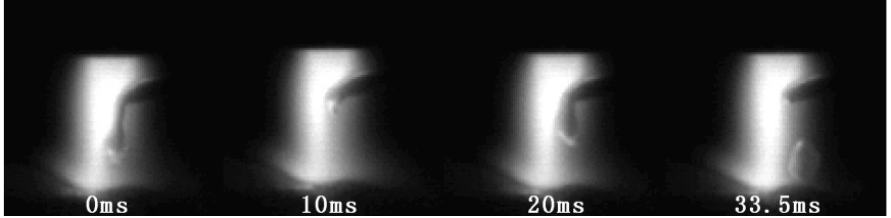
Figure 4. Metal transfer type when the distance between the wire tips and work pieces is 1 mm.